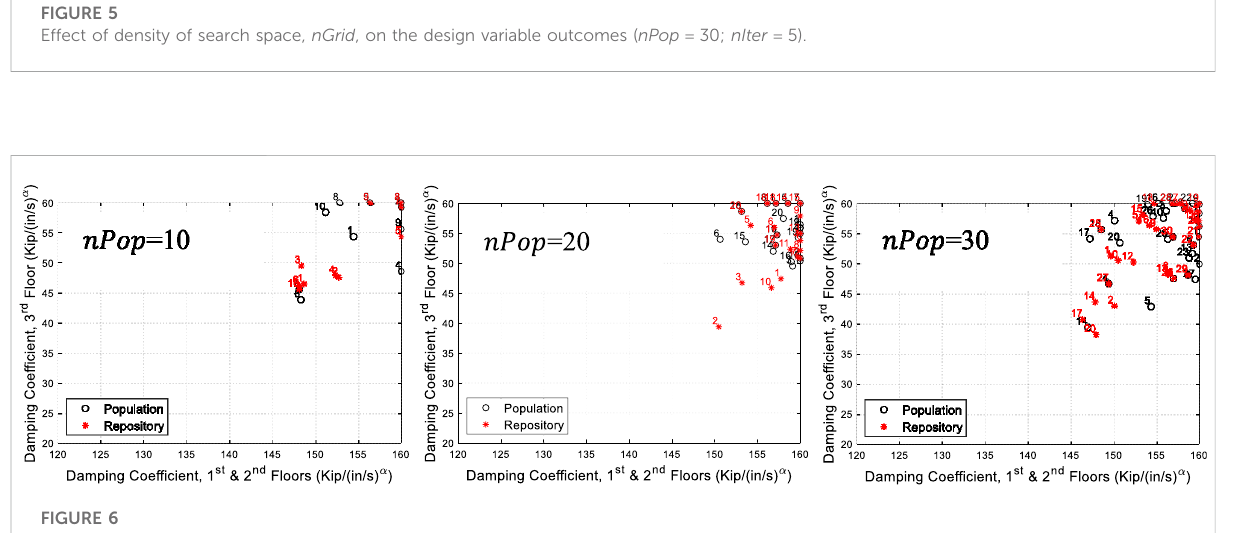
Frontiers in Built